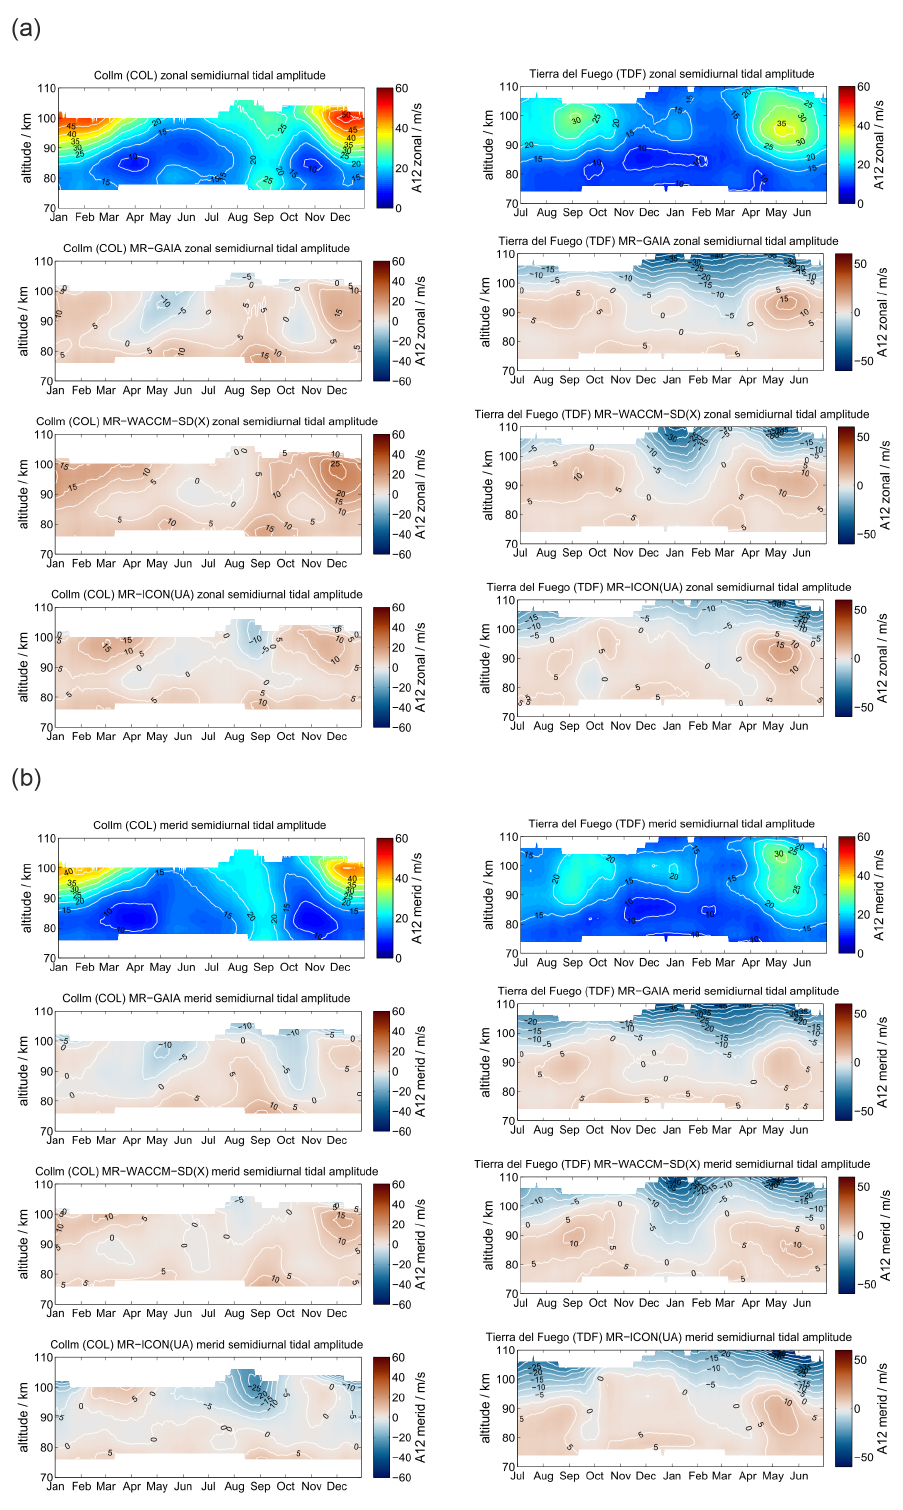
Figure D2. The same as Fig. D1, but for COL and